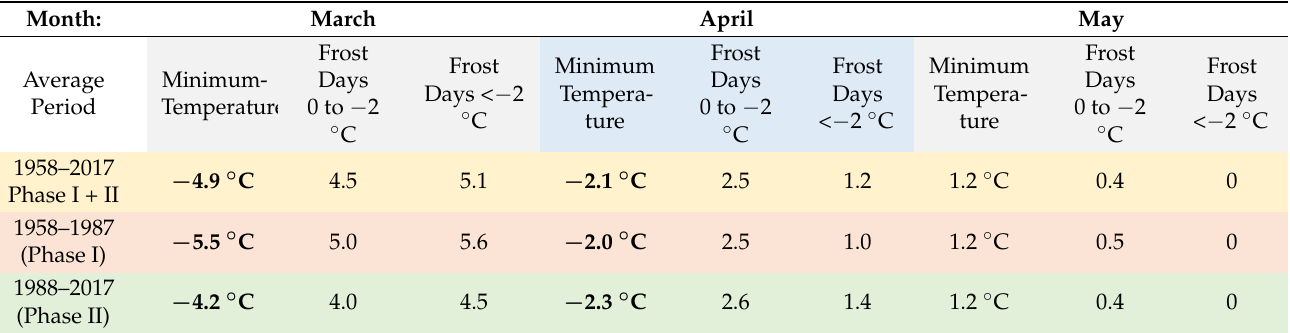
Table 2. Average monthly minimum temperature (Tmin) and frost days less than 0 °C and less than − 2 °C from March to May in the last 60 years at Klein-Altendorf.